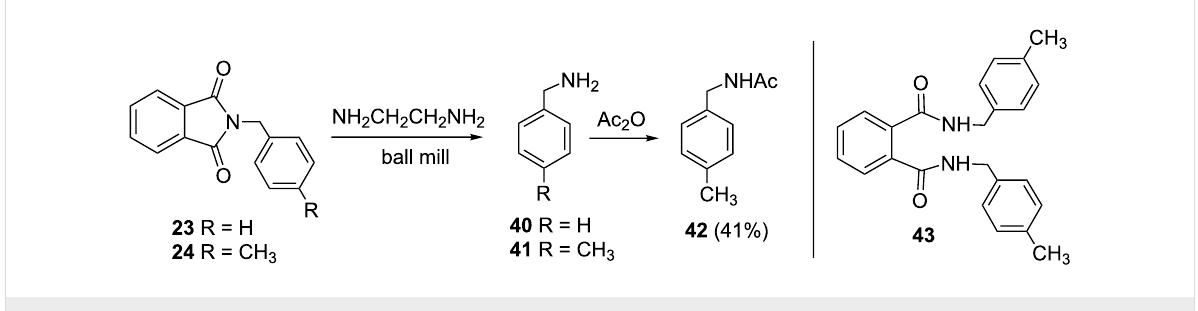
Scheme 4: Gabriel synthesis of amines in ball mill.